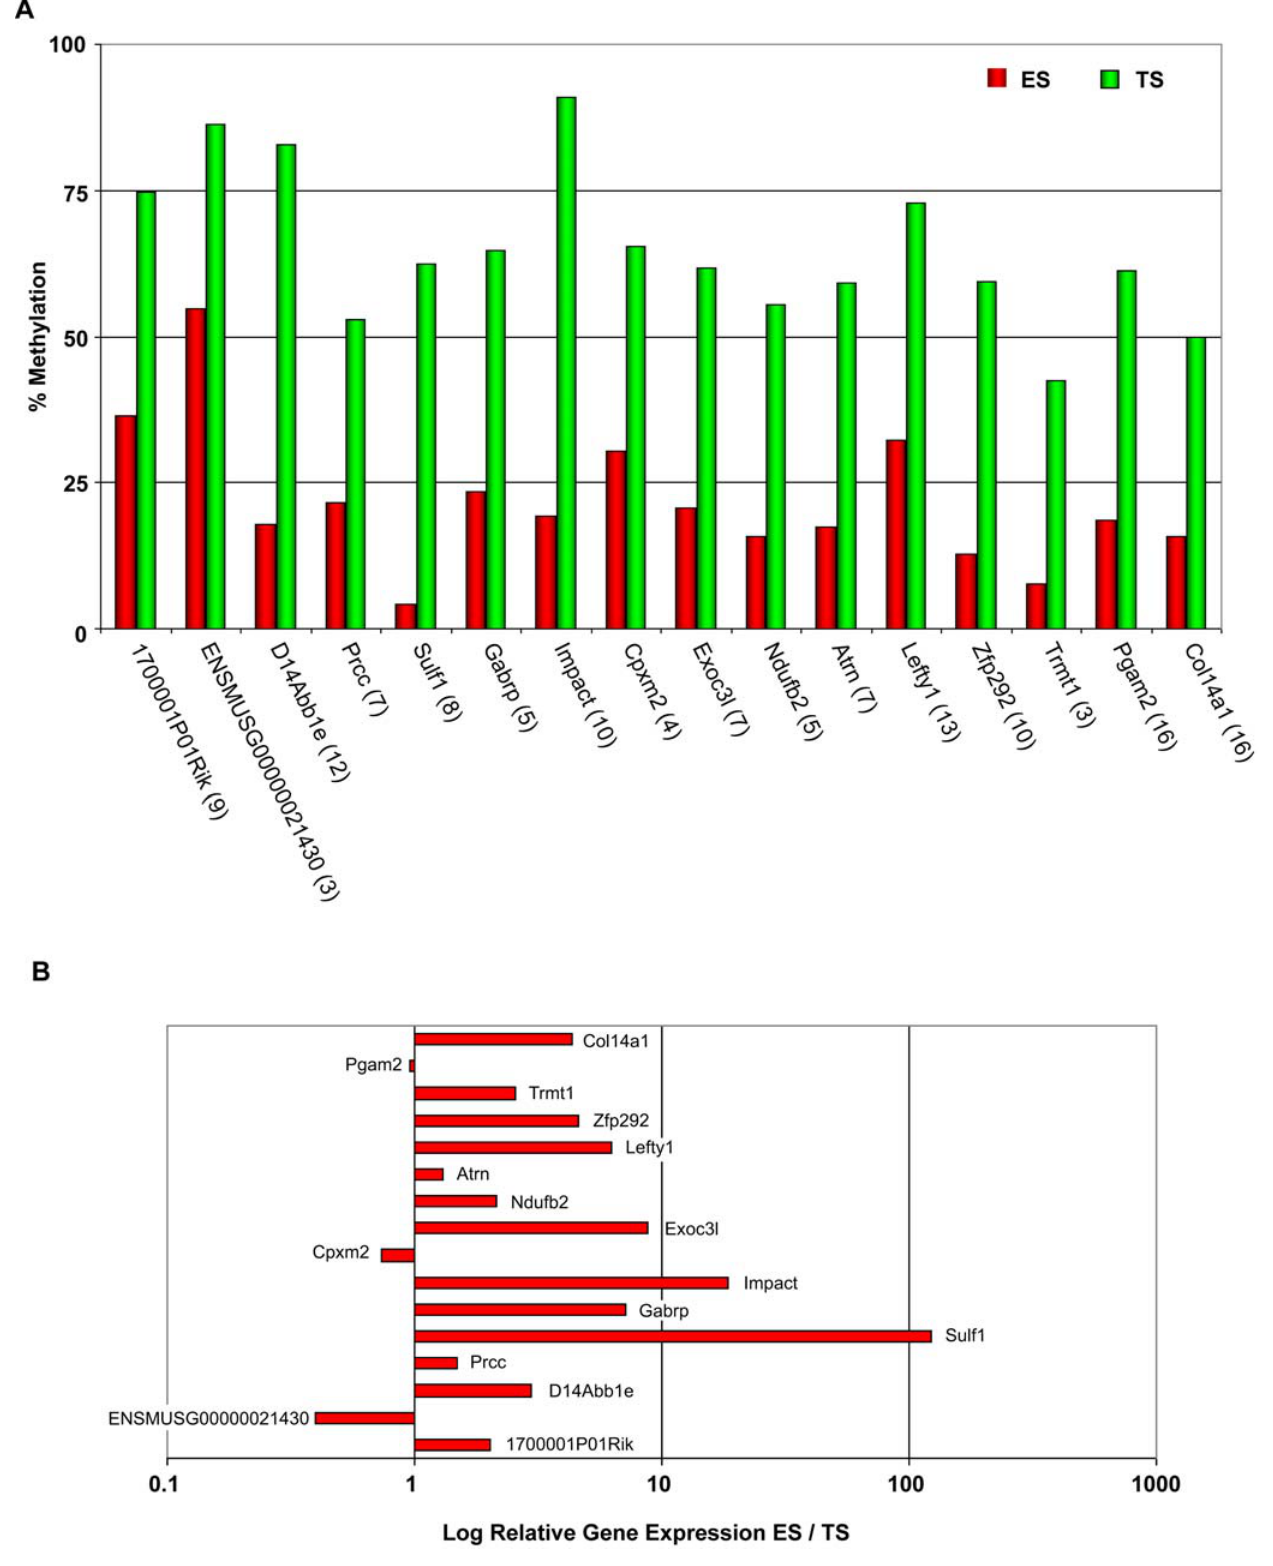
Figure 4. Promoter methylation and gene expression compared between ES and TS cells. (A) Promoter methylation patterns in ES cells (red bars) and TS cells (green bars). Candidate promoter regions were identified by the meDIP screen and validated by Sequenom analysis. The number of differentially methylated CpGs analysed for each gene are given in brackets. (B) Gene expression differences between ES and TS cells as determined by quantitative RT-PCR analysis. The x -axis gives the log-fold expression difference between the cell types (i.e., log [ ES / TS ]). Three reference genes ( Dynein , Pmm1 and Sdha ) were used for normalization.